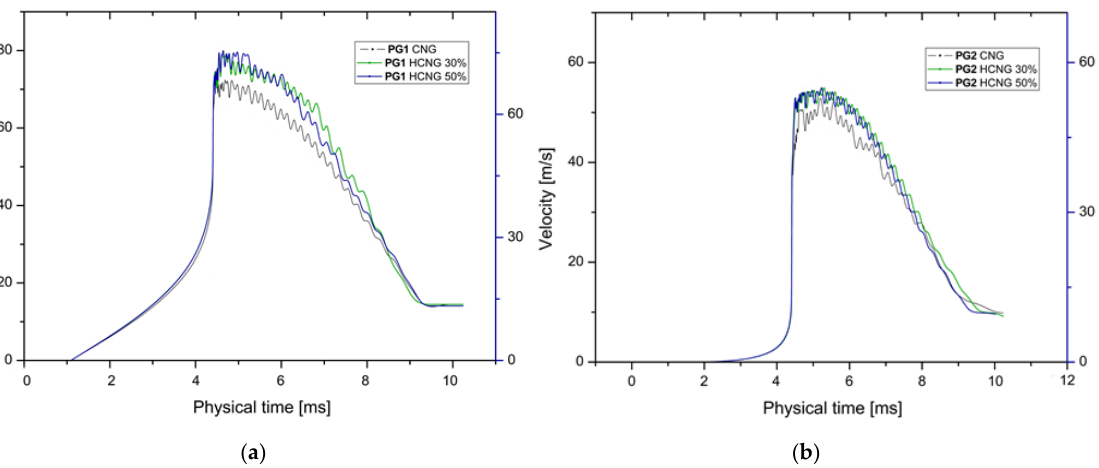
Figure 9. ( a ) Unsteady in-cylinder flow in the PG1 location; ( b ) Unsteady in-cylinder flow in the PG2 location